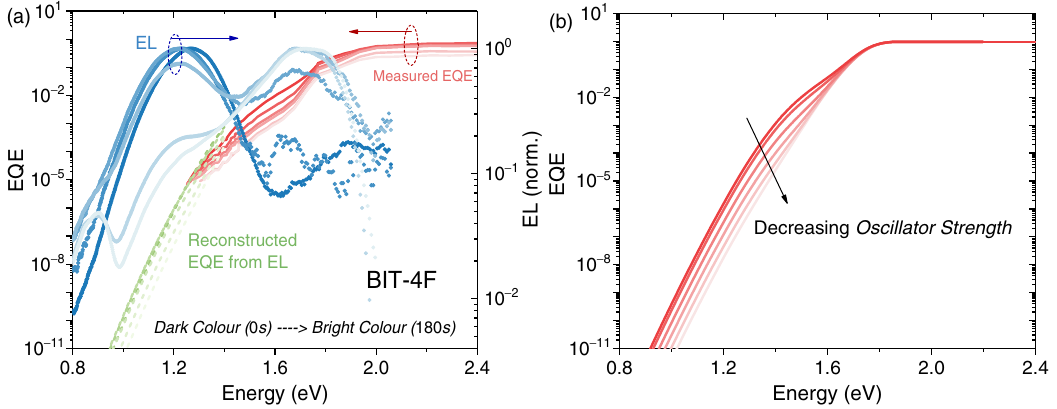
FIG. 3. (a) EL and EQE for BIT-4F:PC71BM blend devices with different SVA processing times. The external quantum efficiencies are composed of the directly measured EQE (red solid lines) and the EQE determined from the EL spectra (blue dashed lines). (b) Reproduced EQE spectra based on the optical model derived above. The different curves are obtained by changing only the oscillator strength of the charge-transfer state, keeping the properties of the excitonic state the same.